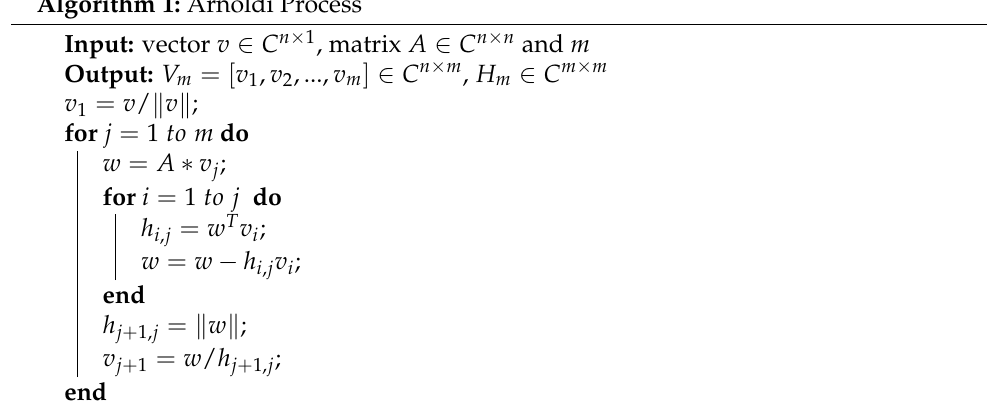
Algorithm 1: Arnoldi